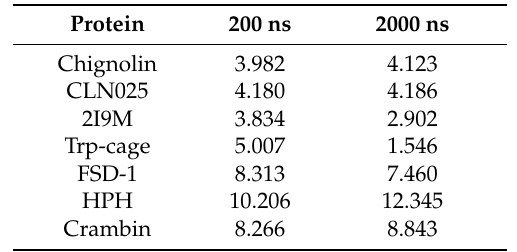
Average RMSDs/Å values between calculated and experimental structures during MD